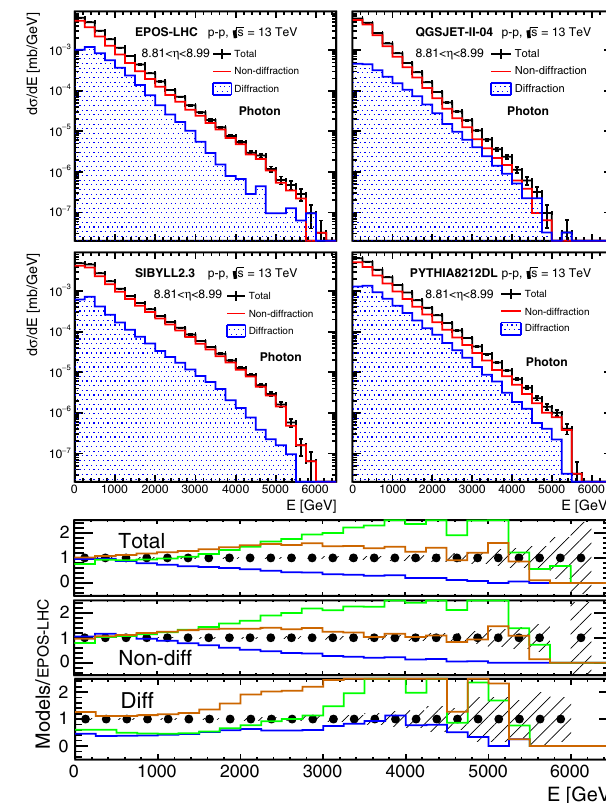
show the ratios of the spectra of EPOS-LHC ( black markers ), QGSJET- II-04 ( blue lines ), SYBILL 2.3 ( green lines ), and PYTHIA8212DL ( orange lines ) to the spectrum of EPOS-LHC. The top , middle , and bottom plots correspond to total,nondiffraction, and diffraction, respec-